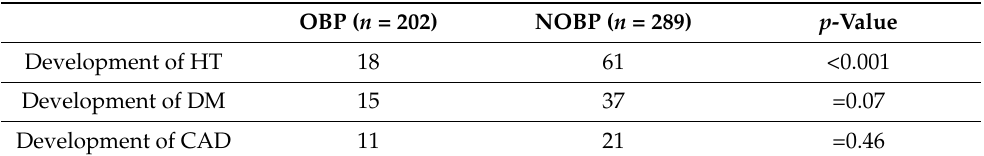
Table 3. Development of Hypertension, diabetes mellitus, and coronary artery disease at 8-year follow-up. OBP ( n = 202) NOBP ( n = 289) p